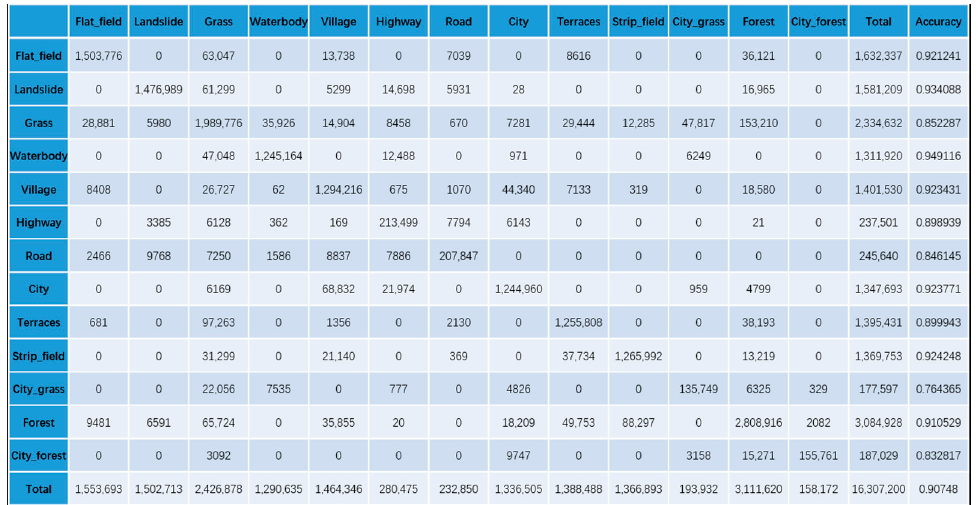
Figure 18. The pixel-based confusion matrix of the KGGCN model.